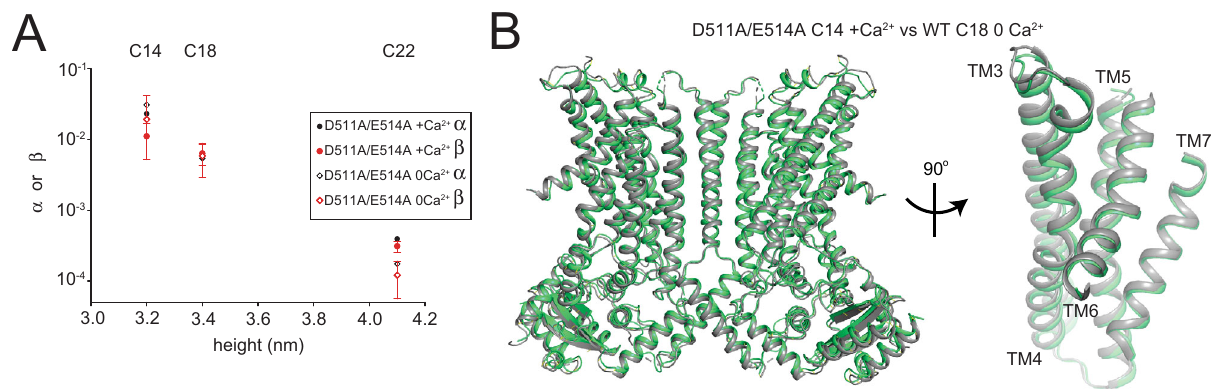
Fig. 5 Functional and structural characterization of afTMEM16 D511A/E514A. A Forward ( α , black circles) and reverse ( β , red circles) scrambling rate constants of D511A/E514A afTMEM16 in 0.5 mM ( fi lled symbols) or 0 Ca 2 + (empty symbols). Values are the mean determined from n = 7 – 9 independent determinations from N = 2 – 3 independent preparations and error bars represent St. Dev. Corresponding lipid compositions are noted above. Raw data is available in the Source Data fi le. B Alignment of afTMME16 D511A/E514A in the presence of Ca 2 + (green) in C14 lipids with wildtype afTMEM16 in 0 Ca 2 + in C18 lipids (gray) with close up view of the permeation pathway. Source data are provided as a Source Data fi